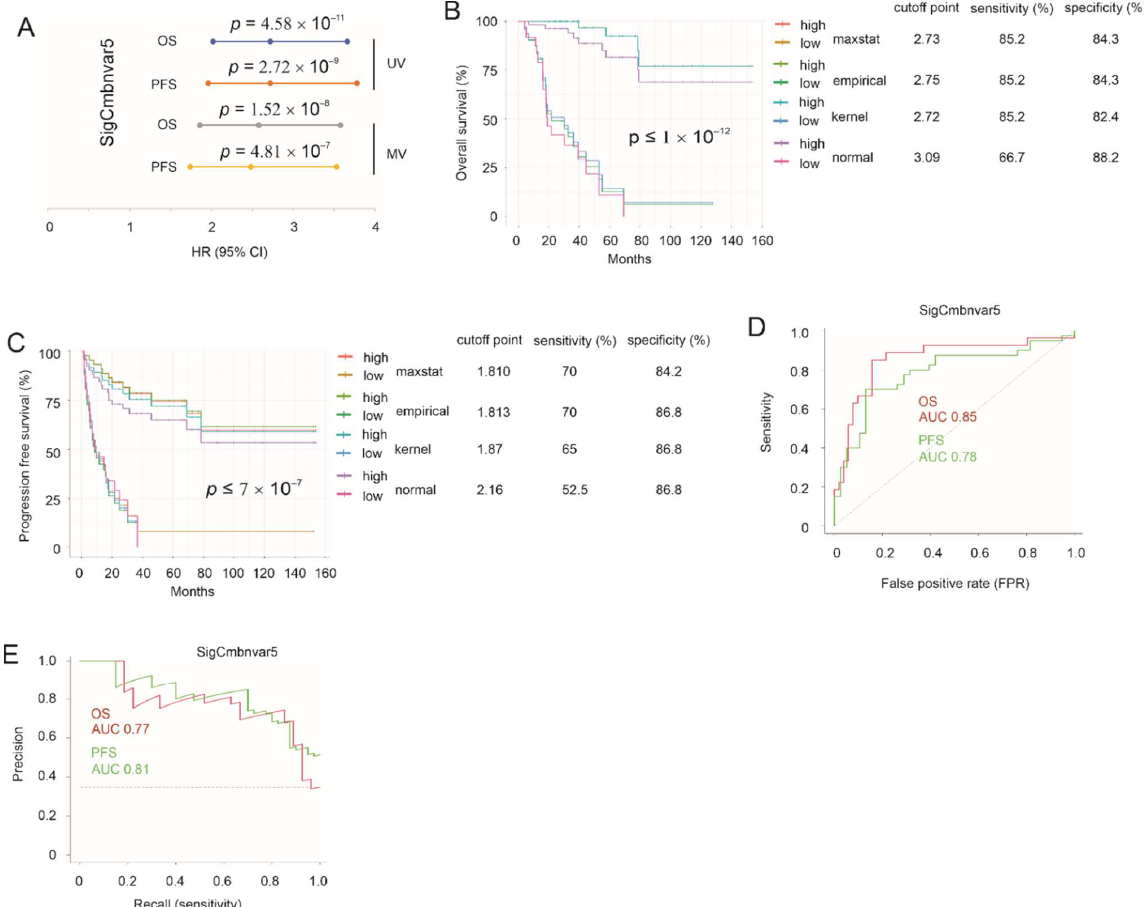
Figure 4. Estimation of ACC progression and fatality risks by SigCmbnvar5. ( A ) HR, 95% CI, and the respective p -values for SigCmbnvar5-derived prediction of OS and PFS under both univariate (UV) and multivariate (MV) settings. MV includes age at diagnosis and tumor stages. ( B , C ) Stratification of ACCs fatality ( B ) and progression risk ( C ) with the indicated cutoff points. ( D , E ) ROC ( D ) and PR curves ( E ) for discrimination of OS and PFS.